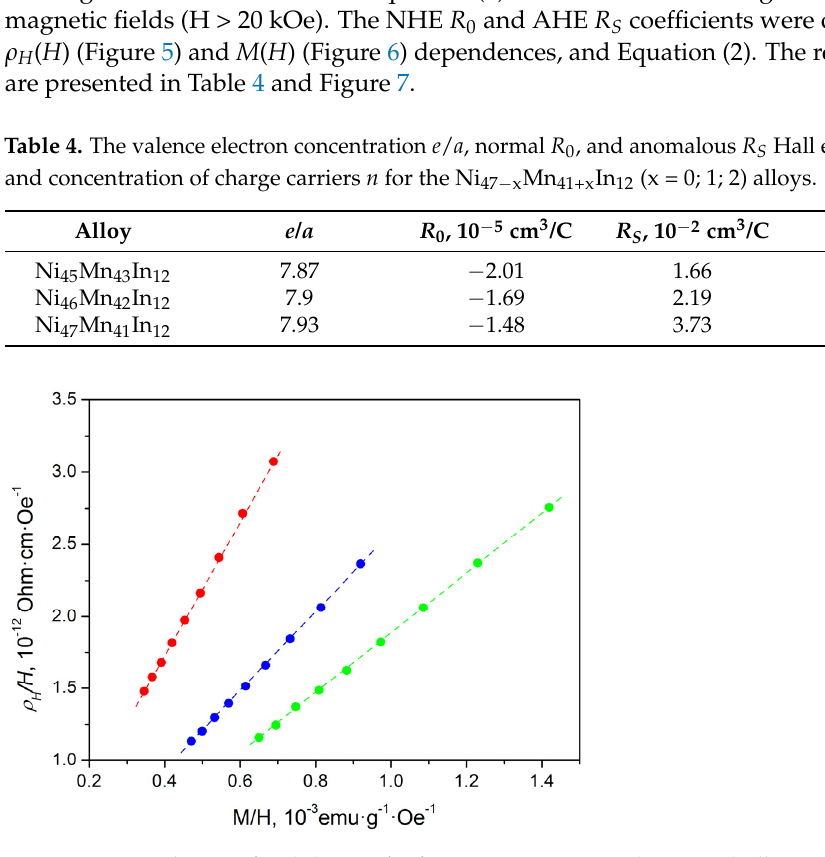
Figure 7. Dependences of ρ H ( H ) on M / H for Ni 47 − x Mn 41+x In 12 (x = 0; 1; 2) alloys at T = 4.2 K: green circles—Ni 45 Mn 43 In 12 , blue circles—Ni 46 Mn 42 In 12 , red circles—Ni 47 Mn 41 In 12 .